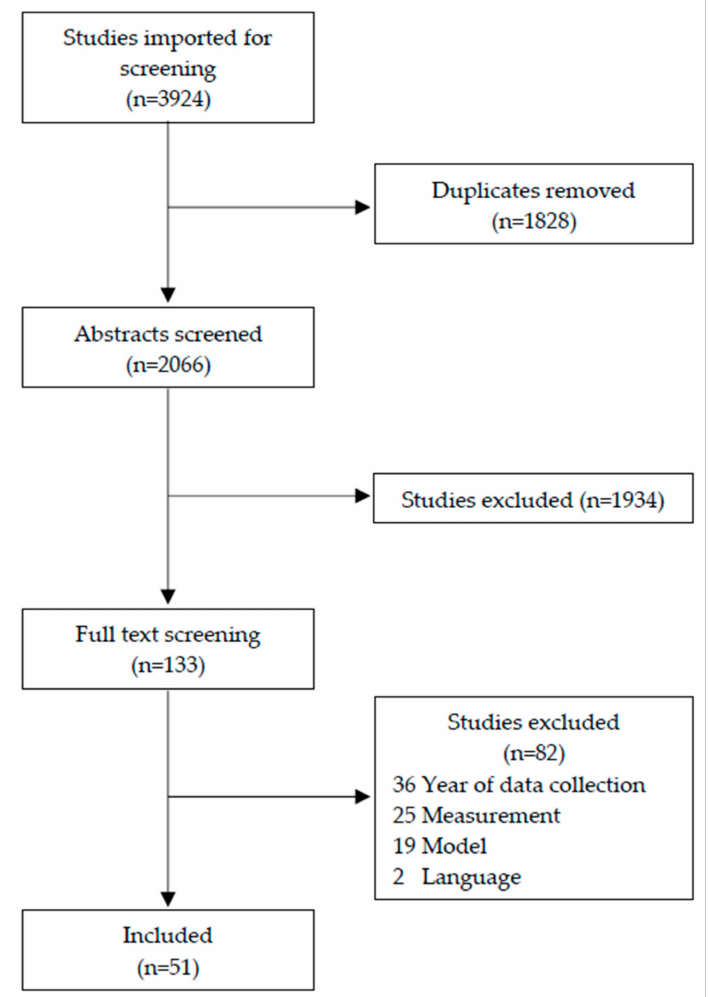
Figure 2. PRISMA flow